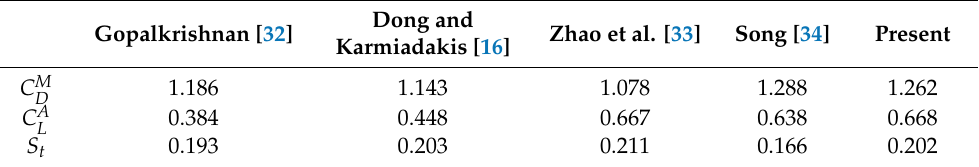
Table 3. Calculation results comparisons of fixed single cylinder.